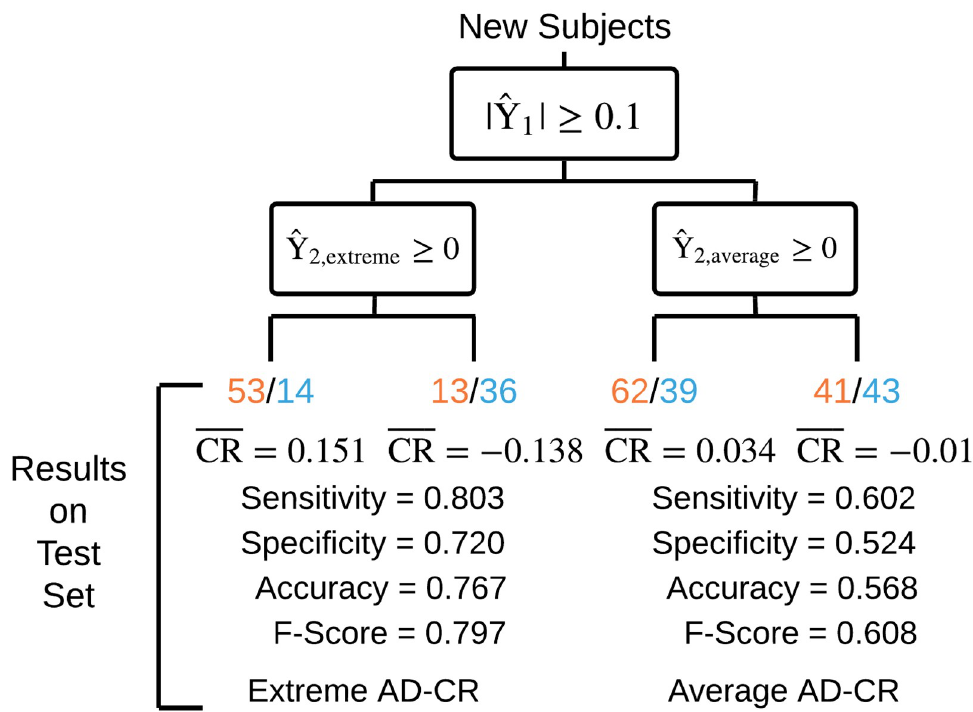
Fig 4. Visual depiction of our two stage machine learning framework and the predictive performance in terms of classifying high AD-CR Scores from low AD-CR Scores on the test set. The first stage model separates subjects into an Extreme AD-CR group and an Average AD-CR group based on whether their predicted AD-CR Scores are above a threshold, j ^ Y j � 0 : 1 . Within each group separately, the second stage model classifies subjects as having either high or 1 low AD-CR, ^ Y � 0 . We report the Sensitivity, Specificity, Accuracy, and F-Score of our machine learning framework 2 when applied to the test set and also report the number of test subjects with high (orange) or low (blue) AD-CR Scores as well as the average AD-CR Score ( CR ) in each of the predicted categories. Overall, our machine learning framework shows promising results in terms of predicting whether an individual will have an extremely high or low AD-CR Score using only baseline measures that are available during the